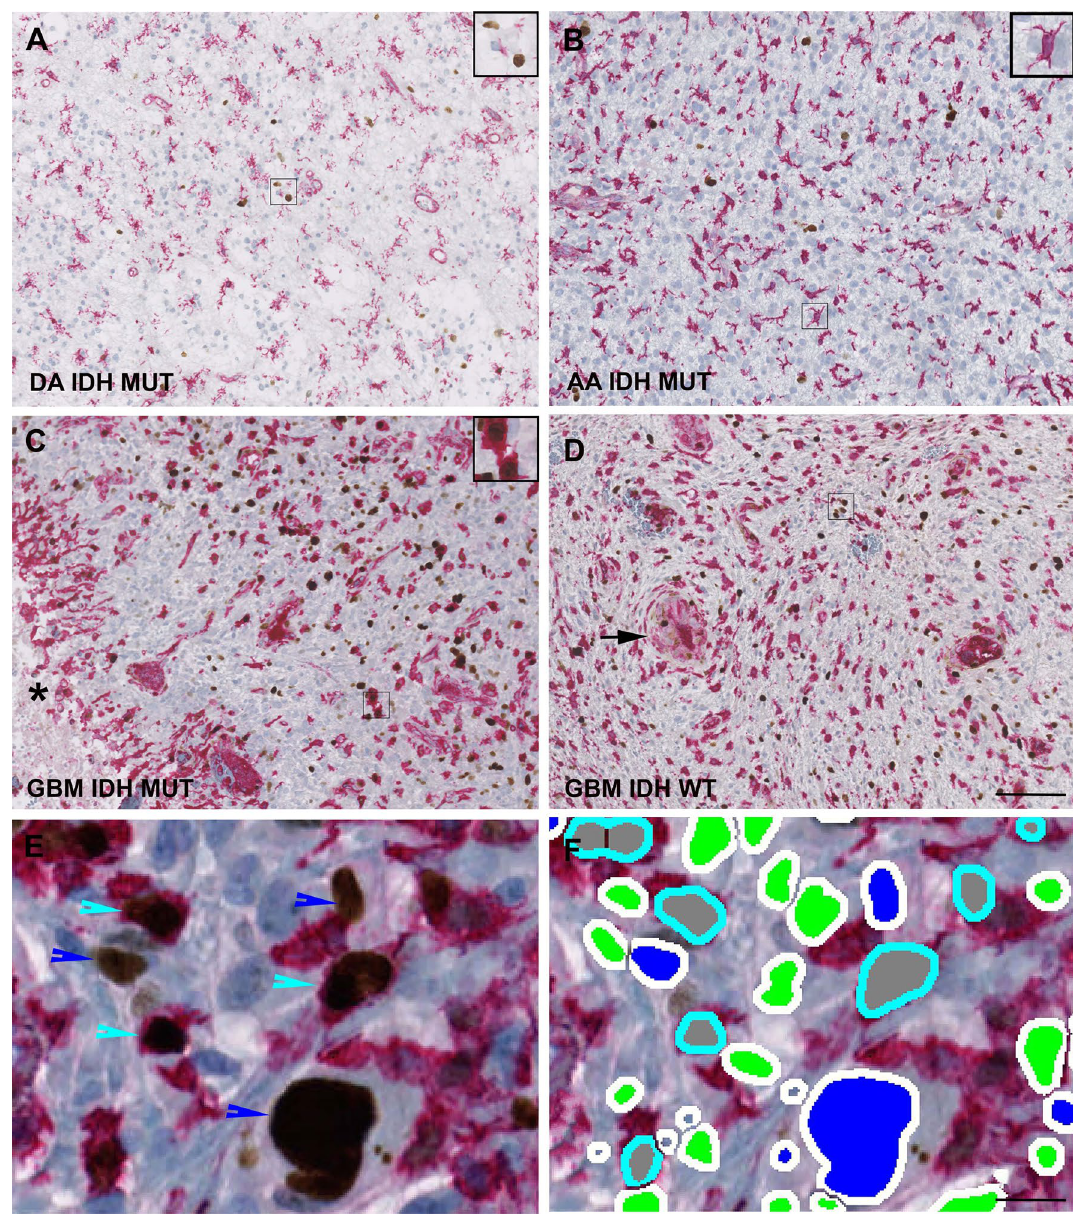
Figure 1. Immunohistochemical expression of Ki-67 (brown) and the exclusion-markers CD45, CD31, Iba1 and ASMA (red)—identified by a double immunohistochemical staining cocktail in astrocytic brain tumors. ( A ) IDH-mutated diffuse astrocytoma (DA) with low cellularity showing only a few scattered Ki-67 positive tumor cells not labeled by red (see insert). ( B ) IDH-mutated anaplastic astrocytoma (AA) with moderate cellularity showing higher presence of Ki-67 positive tumor cells not labeled by red. ( C ) IDH-mutated glioblastoma (GBM) and ( D ) IDH-wildtype glioblastoma with high cellularity and increased number of Ki-67 positive tumor cells not labeled by red. An increased fraction of non-tumor cells also expressed Ki-67 (see insert in C). The appearance of pseudopalisading necrosis with pink positive staining of microglia/macrophages (black asterix) and microvascular proliferations with pink positive staining of endothelial/smooth muscle cells (black arrow) are shown respectively in ( C ) and ( D ). ( E + F ) The staining was quantified by a software-based classifier identifying tumor cells having Ki-67 positive nuclei and not being labeled by red (blue arrowhead, blue label), non-tumor cells having Ki-67 positive nuclei and red cytoplasm (turquoise arrowhead, gray label) and supposed Ki-67 negative tumor cells not being labeled by red (green label). Magnification by × 20 ( A - D ) and × 80 ( E – F ). Scale bar indicates 100 µm ( A - D ), 25 µm ( E – F